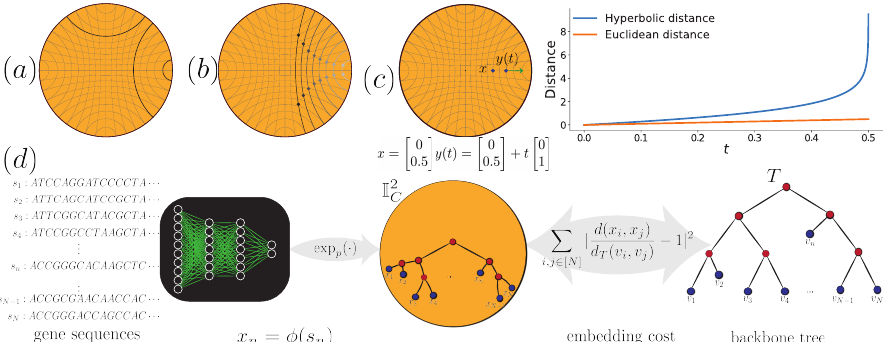
Figure 1. ( a ) Lines (or geodesics) in hyperbolic space. Bold lines are parallel to each other. ( b ) From left to right, the hyperbolic distance between the same-colored points remains constant as they get closer to the boundary of the space. ( c ) Hyperbolic distances grow unboundedly as points move towards the boundary. ( d ) The framework of H-DEPP: the goal is to learn an embedding mapping from sequences to the hyperbolic space while preserving backbone tree